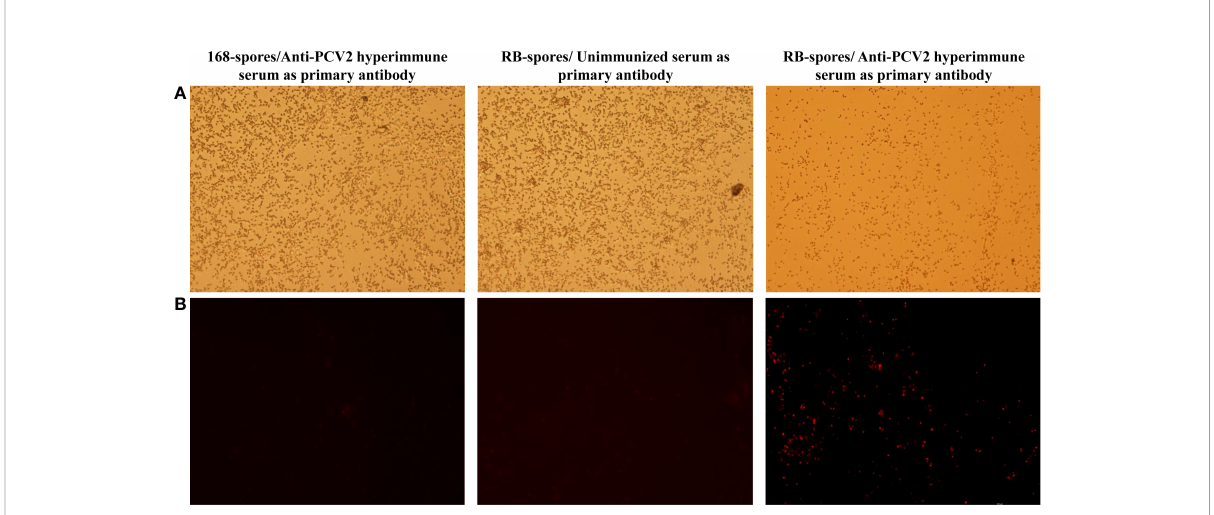
FIGURE 3 Indirect immuno fl uorescence assay of the sporulated B . subtilis RB and B . subtilis 168 strains. (A) Spores of B . subtilis 168 under and RB under 40×bright- fi eld of fl uorescence microscopy (B) Spores of B . subtilis 168 and RB under 40× fl uorescence fi eld, with different serum as primary antibodies and Cy3- conjugated goat anti-mouse IgG was used as secondary antibody. Only the spores of B . subtilis RB incubated with mouse- derived anti- PCV2 hyperimmune serum emit fl uorescent signals in the fl uorescent fi eld.